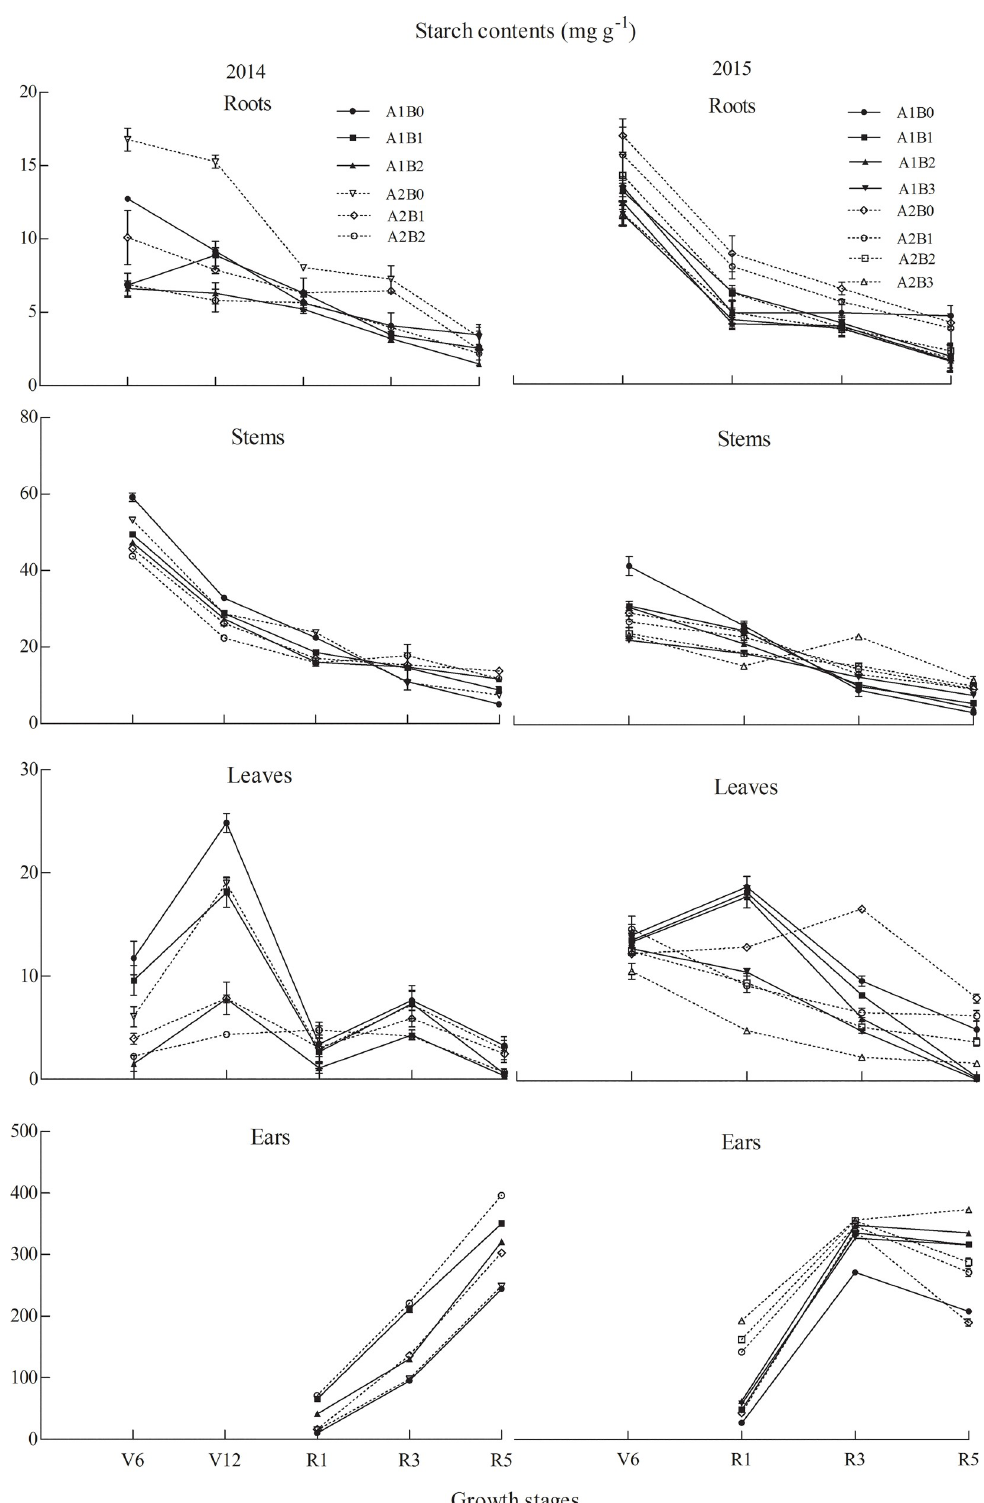
Fig 7. NSC content in different growth periods of maize under various treatments. Note: V6, jointing (V6); V12, big trumpet; R1, silking (R1); R3, milk-ripe; and R5, maturity. A stands for cultivars: A1, ZH311; A2, XY508. B stands for N treatments: B0, 0 kg � ha -1 ; B1, 150 kg � ha -1 ; B2, 300 kg � ha -1 ; and B3, 450 kg � ha -1 .The point in R5 indicates soluble sugar content in grains.